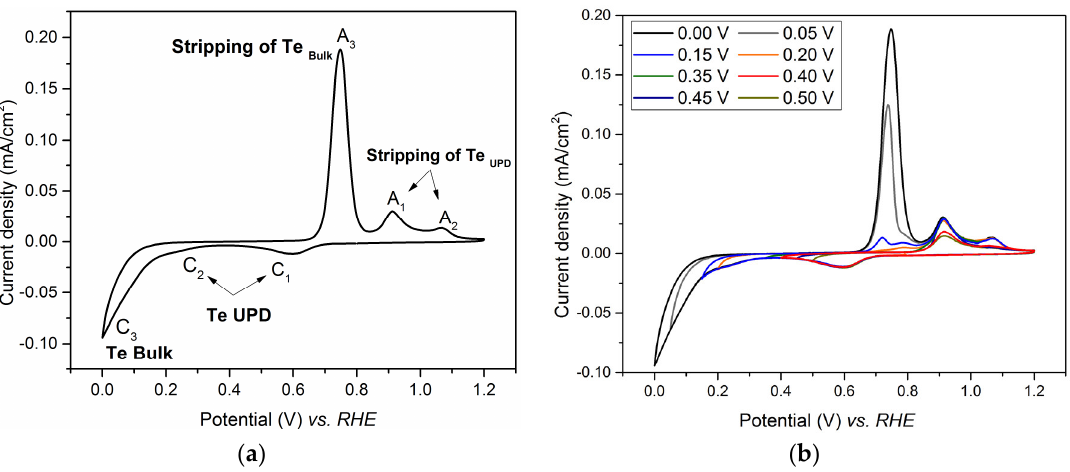
Figure 1. Cyclic voltammetry (CV) of the gold substrate in a solution of 0.4 M HClO 4 and 1 mM TeO 2 (pH 1.0) at a potential sweep rate of 40 mV/s. ( a ) CV obtained by scanning the potential from 1.20 V to 0.00V vs. RHE; ( b ) CV obtained by scanning the potential from 1.20 V to progressively lower potential limits (0.50 V, 0.45 V, 0.40 V, 0.35 V, 0.20 V, 0.15 V, 0.05 V and 0.00 V vs. RHE).